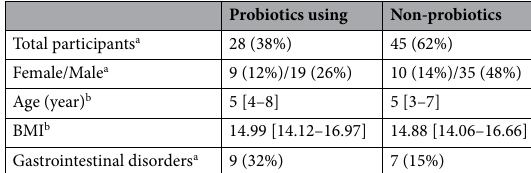
Table 2. The age of children according to probiotics supplementation. BMI body mass index. a Number of cases (percentage). b Median [interquartile